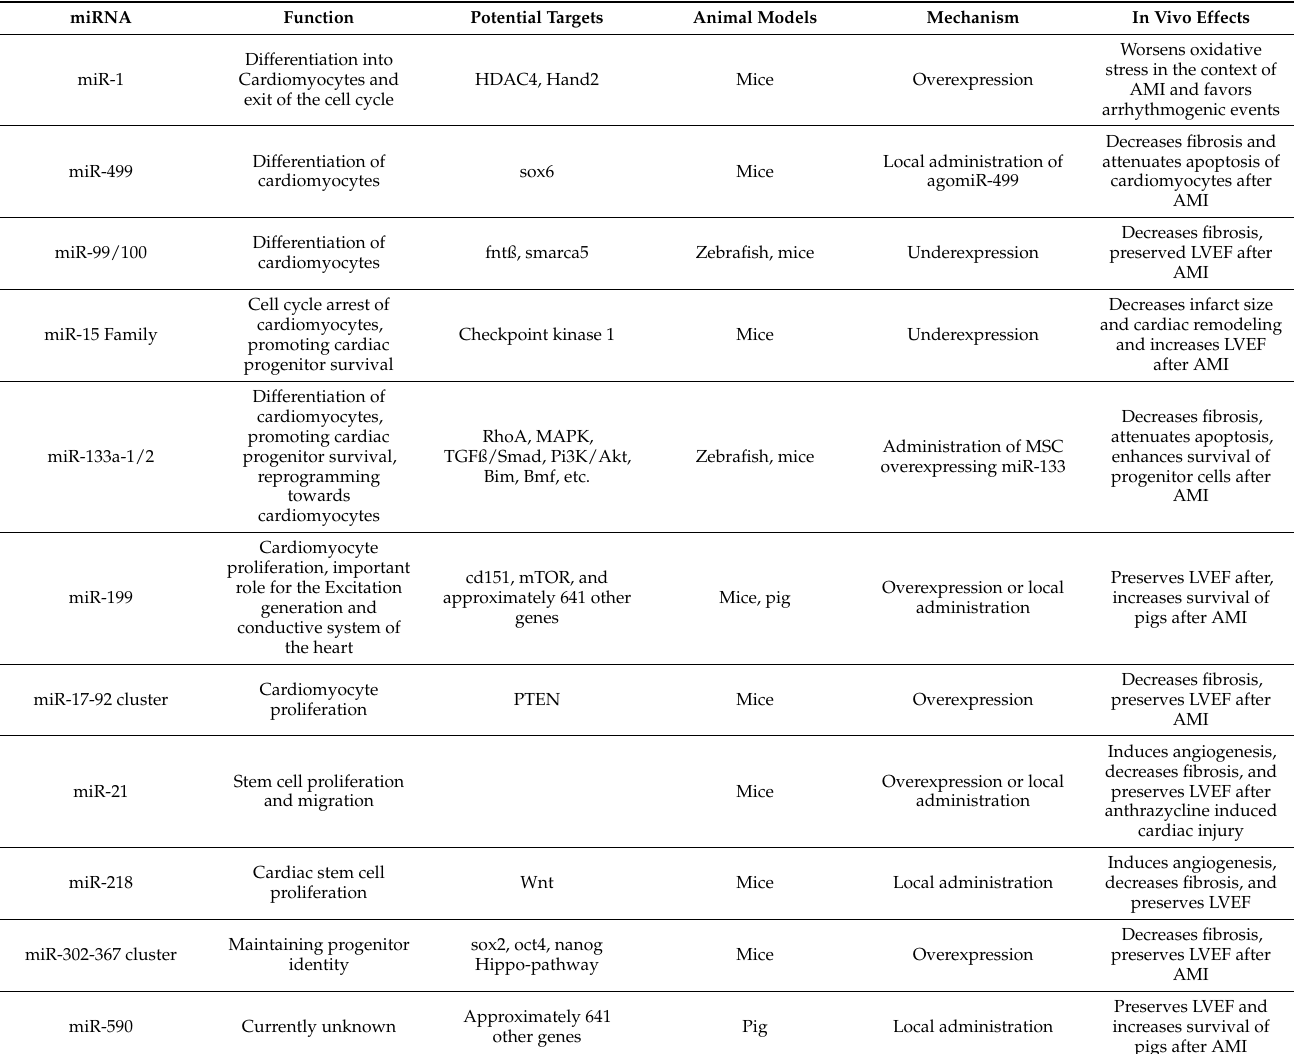
Table 1. Summary of miRNAs considered to be involved in stem cell regulation and cardiac